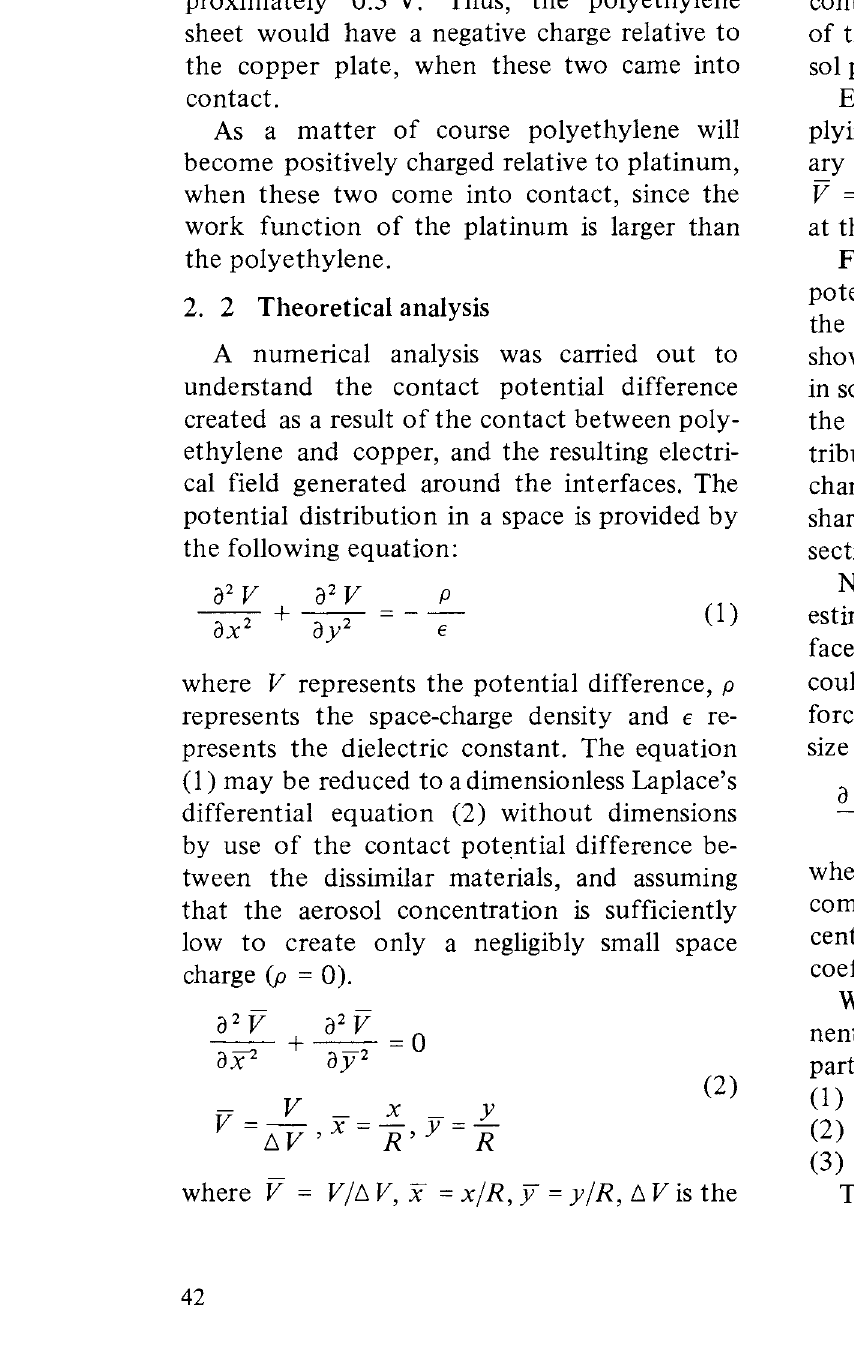
Fig. 6 Calculated electric potential